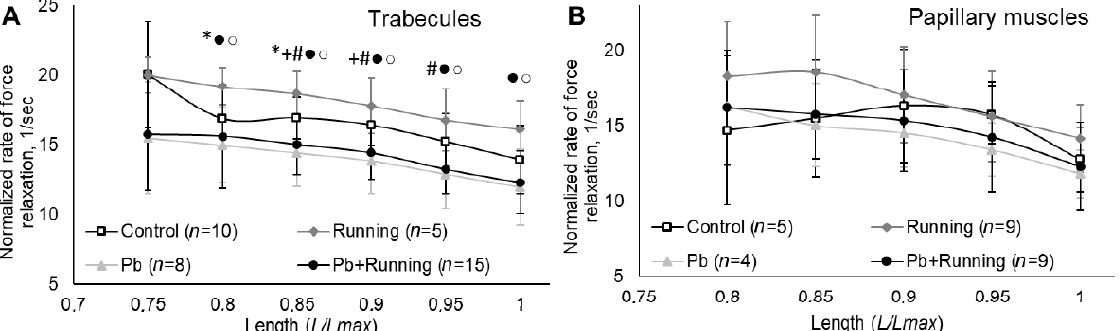
Figure 5. The relationships between normalized rate of force relaxation and relative muscle length of trabecules ( A ) and papillary muscles ( B ) in the experimental groups. The number of preparations is given in brackets. Muscle length is shown in Lmax units. Data are presented as mean ± S.D. There are significant differences (by Mann–Whitney U-test): *—”Running” vs. “Control”; +—”Pb” vs. “Control”; #—”Pb + Running” vs. “Control”; ● —”Pb + Running” vs. “Running”; ○ —”Pb” vs. “Running”.